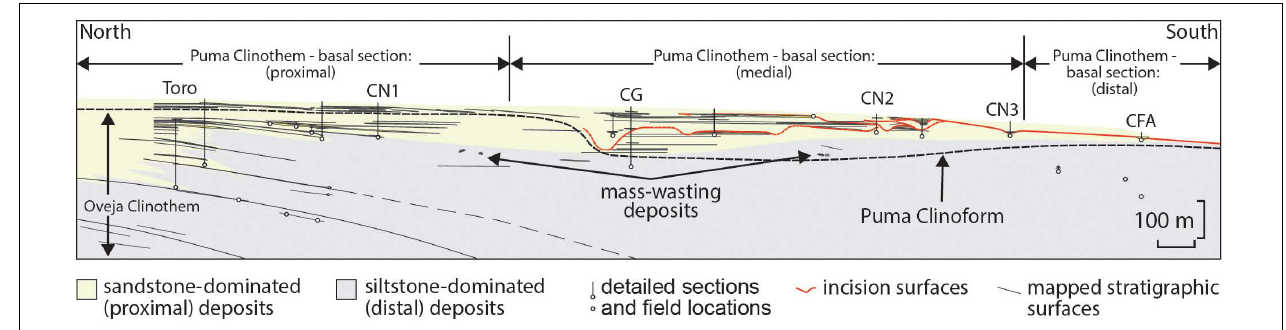
FIGURE 12 | Depositional dip-oriented cross-section (no vertical exaggeration) of the proximal through distal Puma basal clinothem package. Main incision surfaces and mapped stratigraphic surfaces, as well as measured section locations, are indicated (key section locations shown in Figure 3